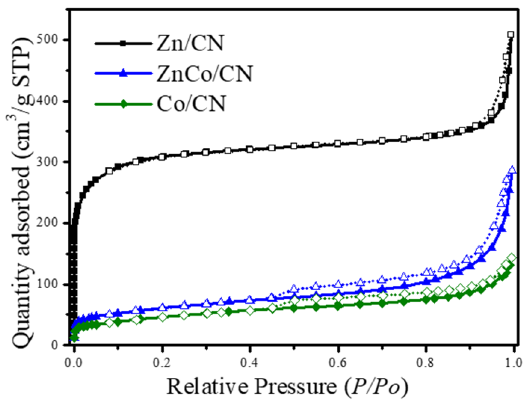
Figure 4. The N 2 isotherms of synthesized porous carbon materials deriving from ZIF templates.